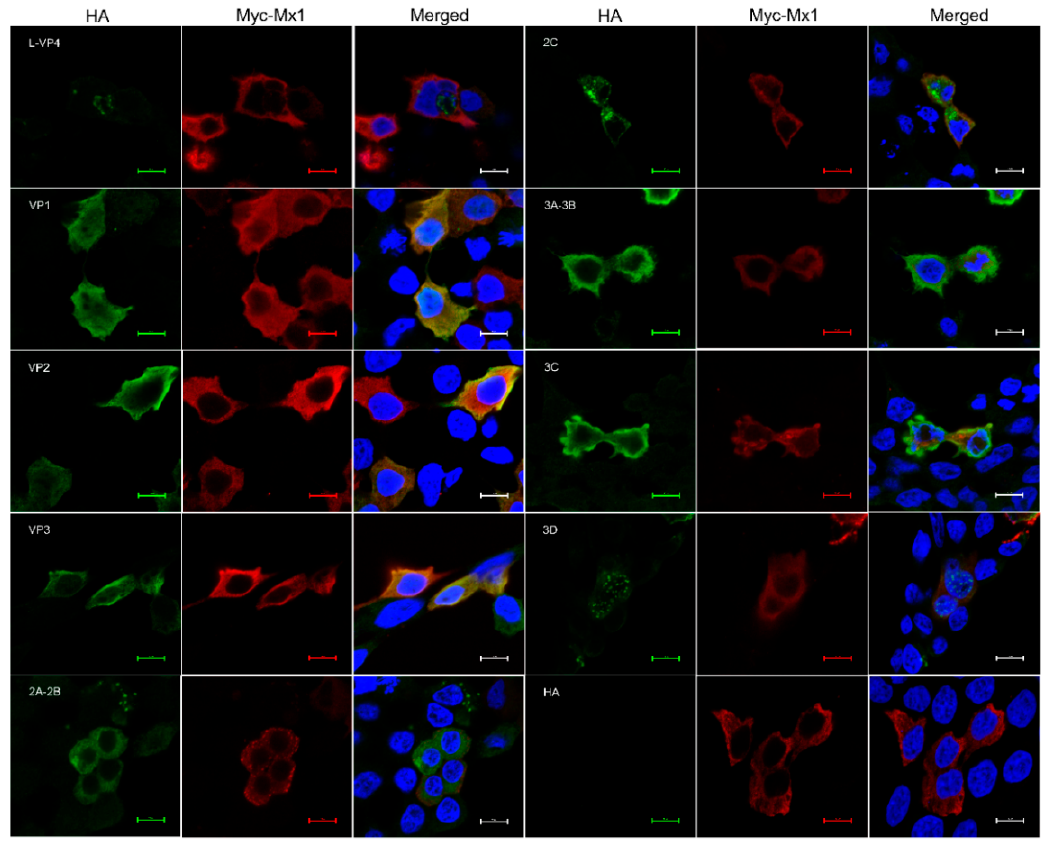
Figure 9. Confocal immunofluorescence microscopy of the colocalization of Mx1 and SVA proteins in co-transfected HEK293T cells. HEK293T cells were co-transfected with 1.25 μ g of pCMV-HA-L-VP4, pCMV-HA-VP1, pCMV-HA-VP2, pCMV-HA-VP3, pCMV-HA-2A-2B, pCMV-HA-2C, pCMV-HA-3A-3B, pCMV-HA-3C, pCMV-HA-3D or pCMV-HA, and 1.25 μ g of pCMV-Myc-Mx1. At 36 hpt, the cells were fixed for confocal microscopy using mouse anti-Myc and rabbit anti-HA mAbs as the primary antibodies. Scale bars, 10 μ m.